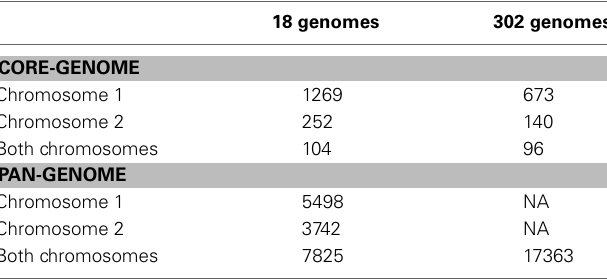
The absolute number shows the amount of GOIDs that were connected to the pathway.Thecolorcodeisasfollows:redisthebiologicalprocess,greenisthe cellular component, and blue is the molecular function.